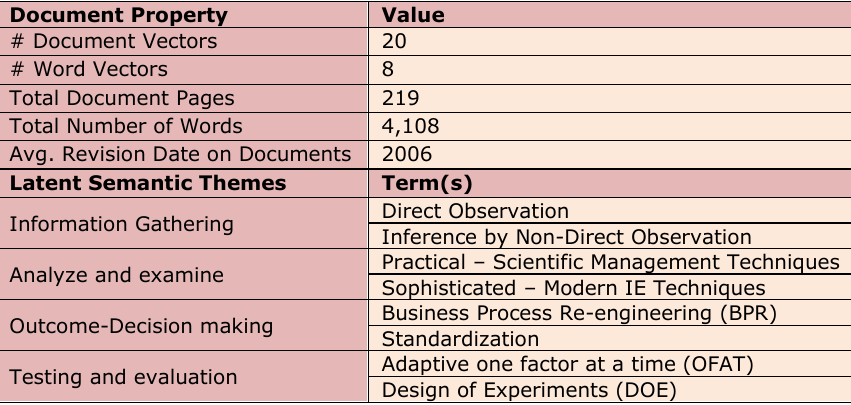
Table 3. Text corpus properties and semantic